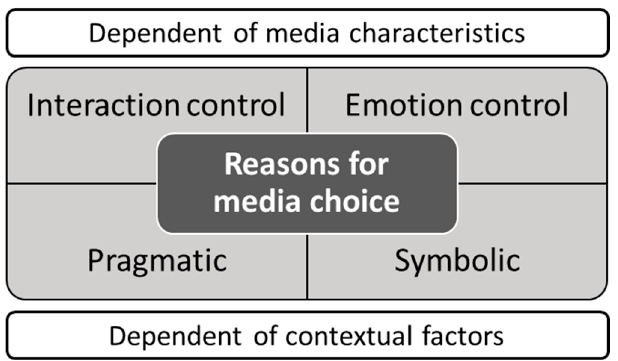
Figure 2. Four categories of reasons for media choice.